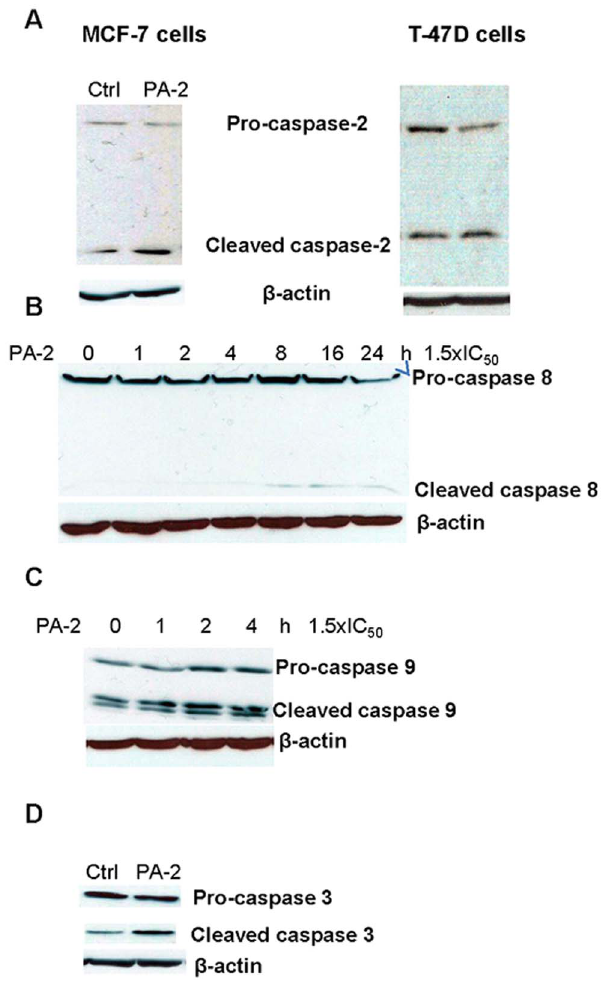
Figure 3. Phospho-aspirin-2 activates caspase cascades. PA-2 treatment in MCF7 or T-47 D cells resulted in decreased expression of pro-caspase-2, -8, -9 and -3 and increased expression of their cleaved forms, as determined by western blot.